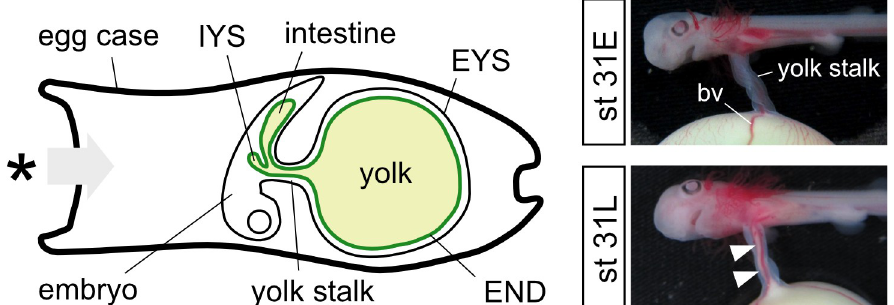
Fig 1. ‘Pre-hatching’ in cloudy catshark. Schematic drawing and pictures of developing catshark embryo around pre- hatching period. The external yolk sac is attached to an embryo via the yolk stalk. Yolk contents inside the